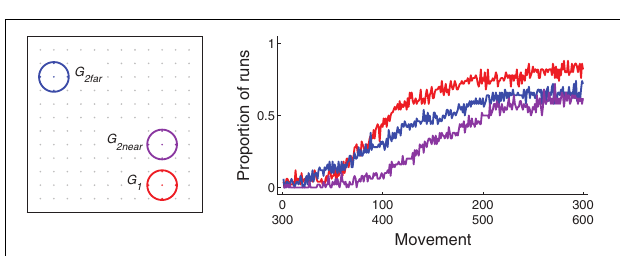
the proportion of runs for which the first and second tar- gets were hit as a function of movement for the different